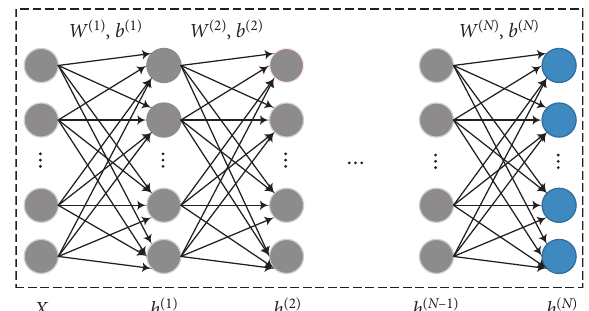
Figure 1: The network architecture used in the method. X is the input of the network, h ( 1 ) − h ( N − 1 ) are the output of the hidden layers, h ( N ) is the output of the top layer, and W ( n ) and b ( n ) are the parameters of the network to be learned, 1 ≤ n ≤ N